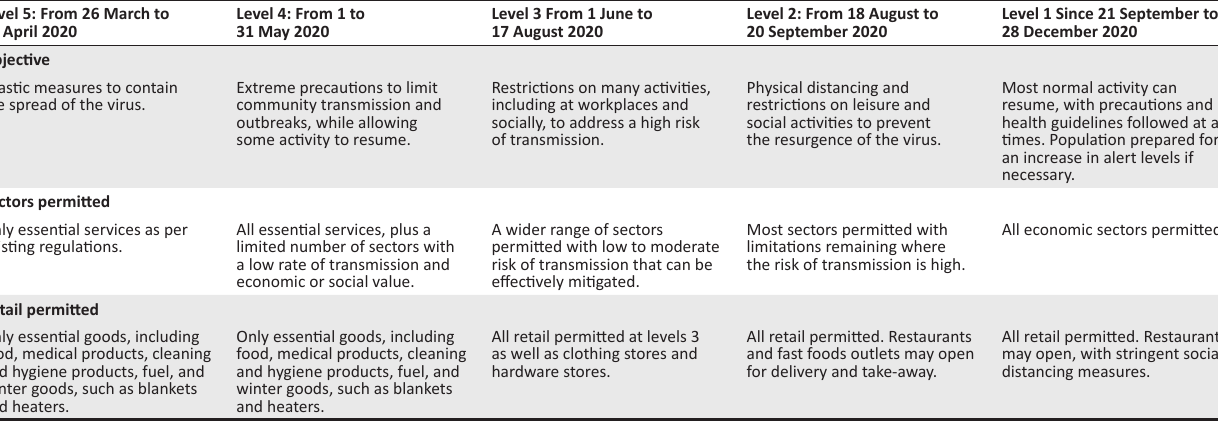
TABLE 1: COVID-19 lockdown levels implemented by South Africa in